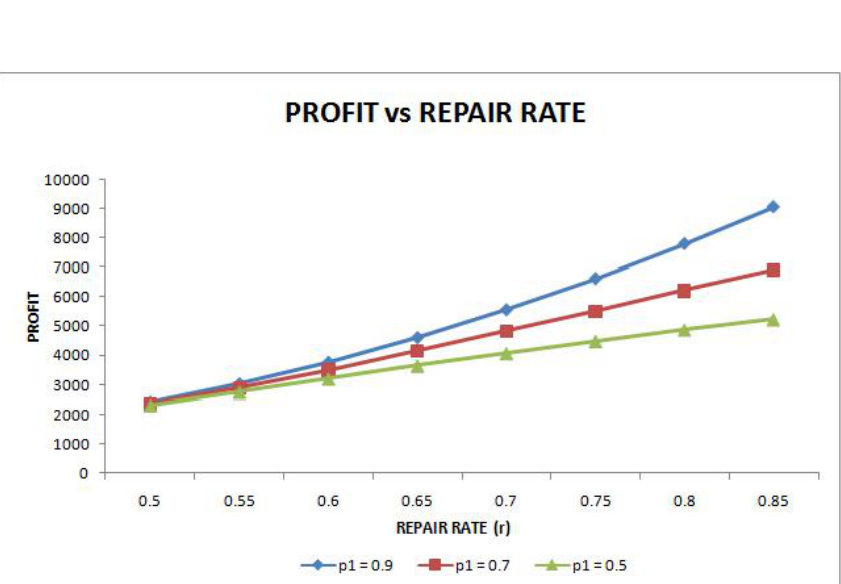
Fig. 5. Profit vs repair